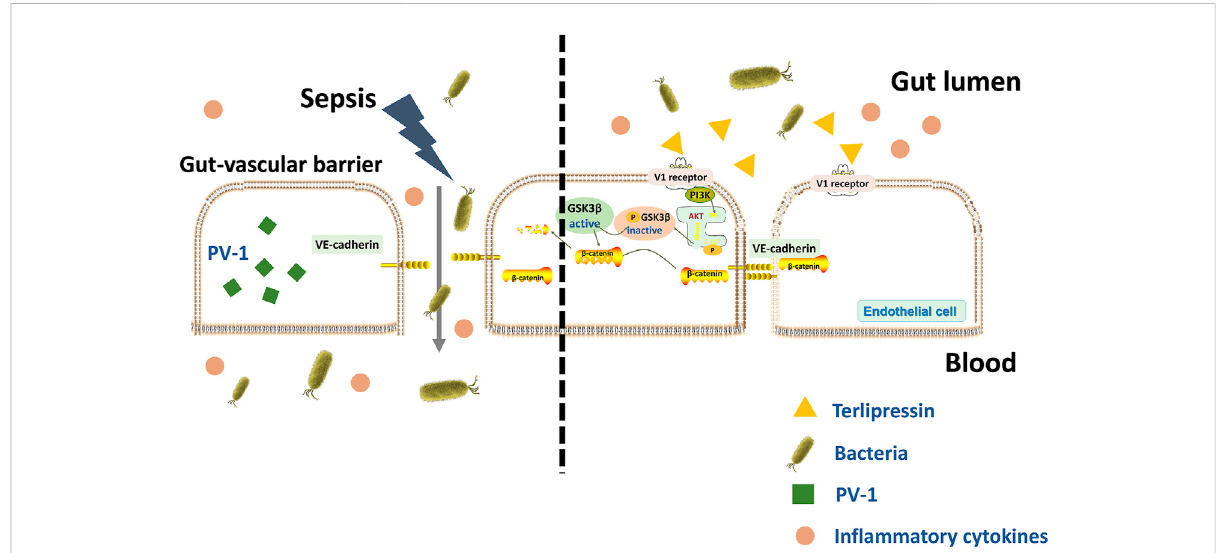
FIGURE 7 A schematic outlining of terlipressin protecting GVB from bacterial translocation into blood and TP/V1/PI3K/ β -catenin signaling pathway in